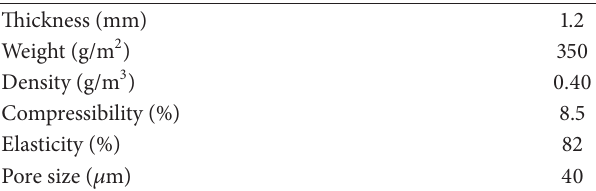
Table 1: Physical properties of the pad supplier.